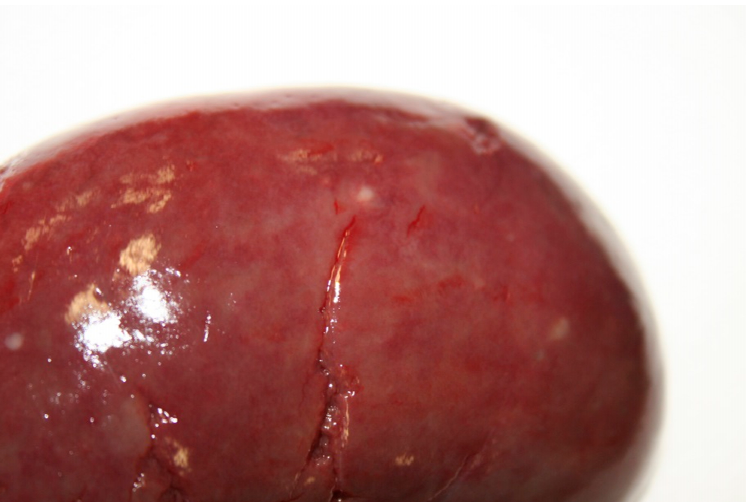
Figure 2. Diffusely congested kidney with white spotting cortical lesions.